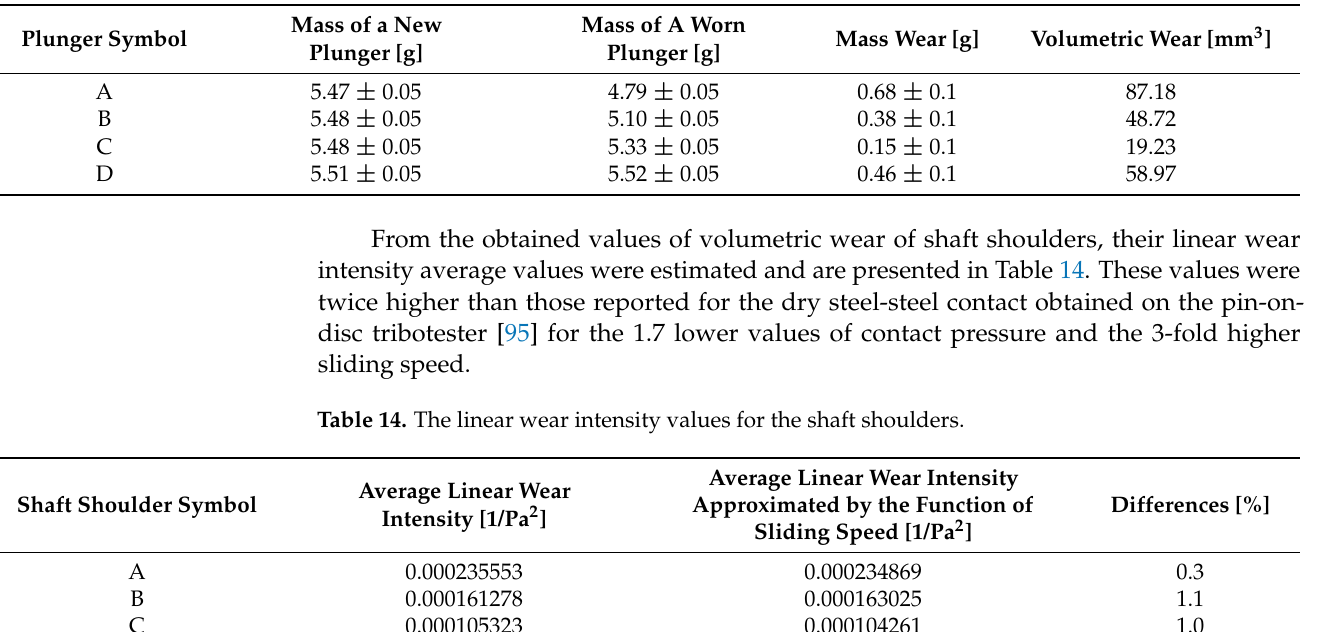
Table 13. The masses of initial and worn plungers, mass wear, and volumetric wear.